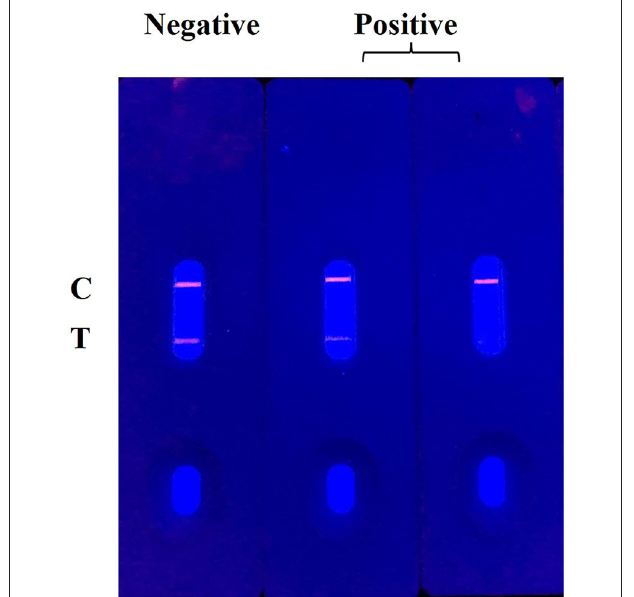
FIGURE 3 | The result of QBs-ICA testing.